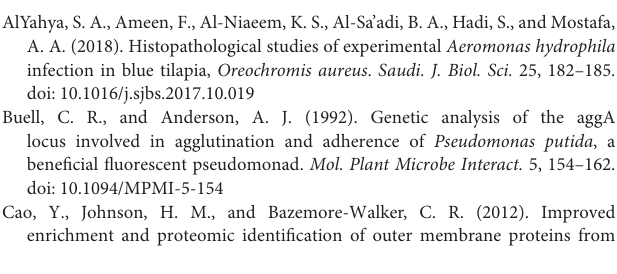
Supplementary Table S1 | Identification and quantitative outer membrane proteomics results of A.h -OXY-O and A.h -OXY-R strains using TMT labeling proteomics analysis (XLS).